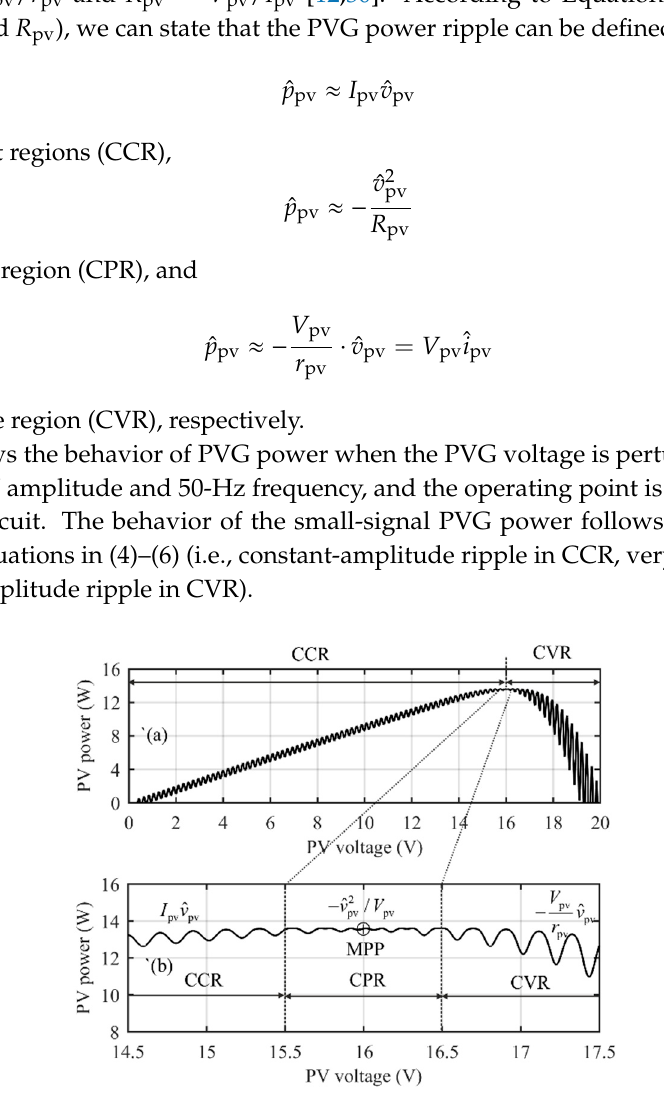
Figure 3. Simulated P-V curve of Raloss SR30-36 PVG (Shanghai Raloss Energy Technology Co. Ltd, Shanghai, PR of China) at the irradiation level of 500 W/m 2 , where the PVG-voltage is perturbed with a 100-Hz sinusoidal voltage having the amplitude of 0.5 V: ( a ) the operating points from short-circuit to open-circuit conditions, ( b ) an extended view of the operating points at the vicinity of MPP.